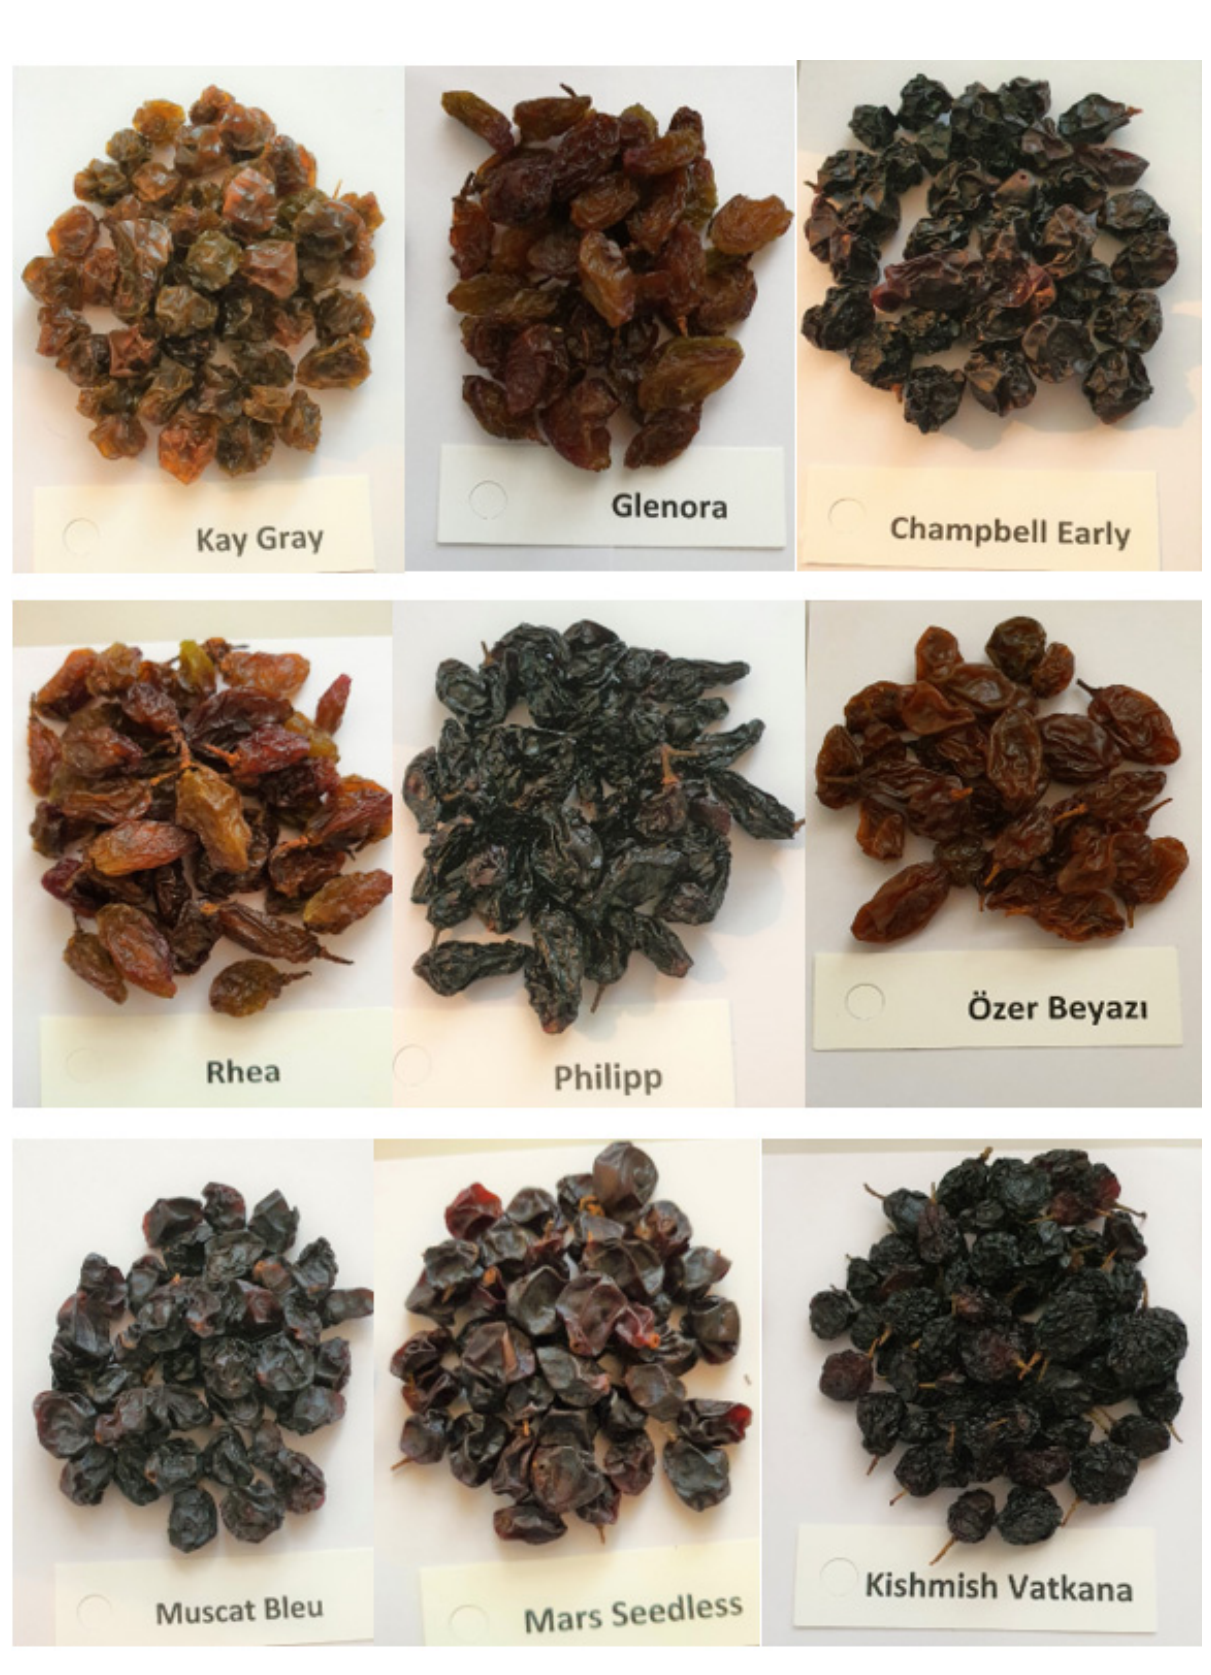
Figure 2. Pictures of raisins obtained from the nine grape cultivars by drying them in an air-pump dryer.